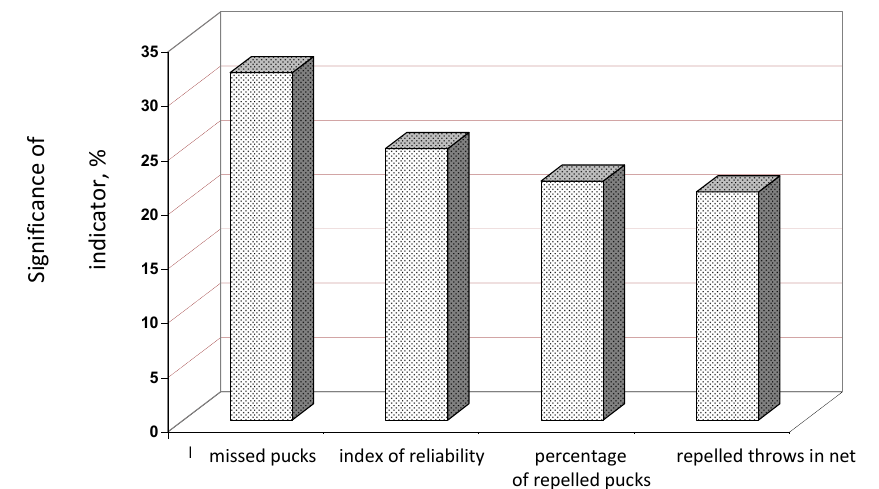
Fig.3. Significance of match indicators for highly qualified hockey goalkeeper (in experts’ opinion,